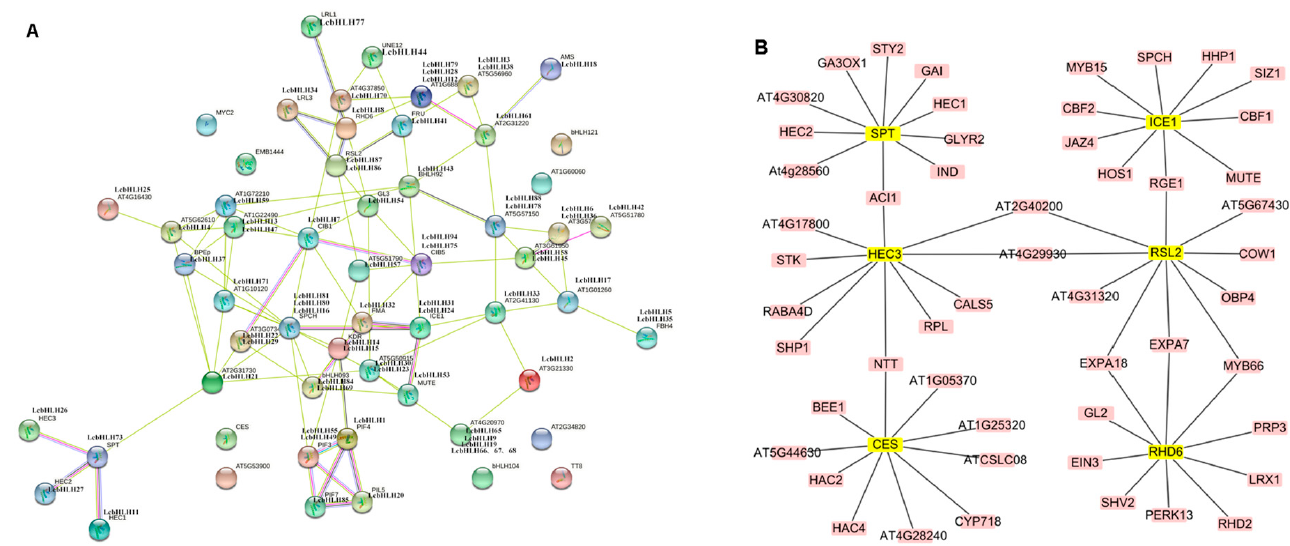
Figure 6. Prediction of LcbHLH protein interaction network based on Arabidopsis orthologs. ( A ) The protein interaction analysis in the LcbHLH family is predicted according to the homology with Arabidopsis thaliana by using a string online website, and the name of LcbHLH protein is marked next to Arabidopsis thaliana orthologous. ( B ) With Cytoscape software, six LcbHLH proteins with high gene homology with Arabidopsis thaliana were predicted and analyzed for extracellular protein interaction prediction according to String website.